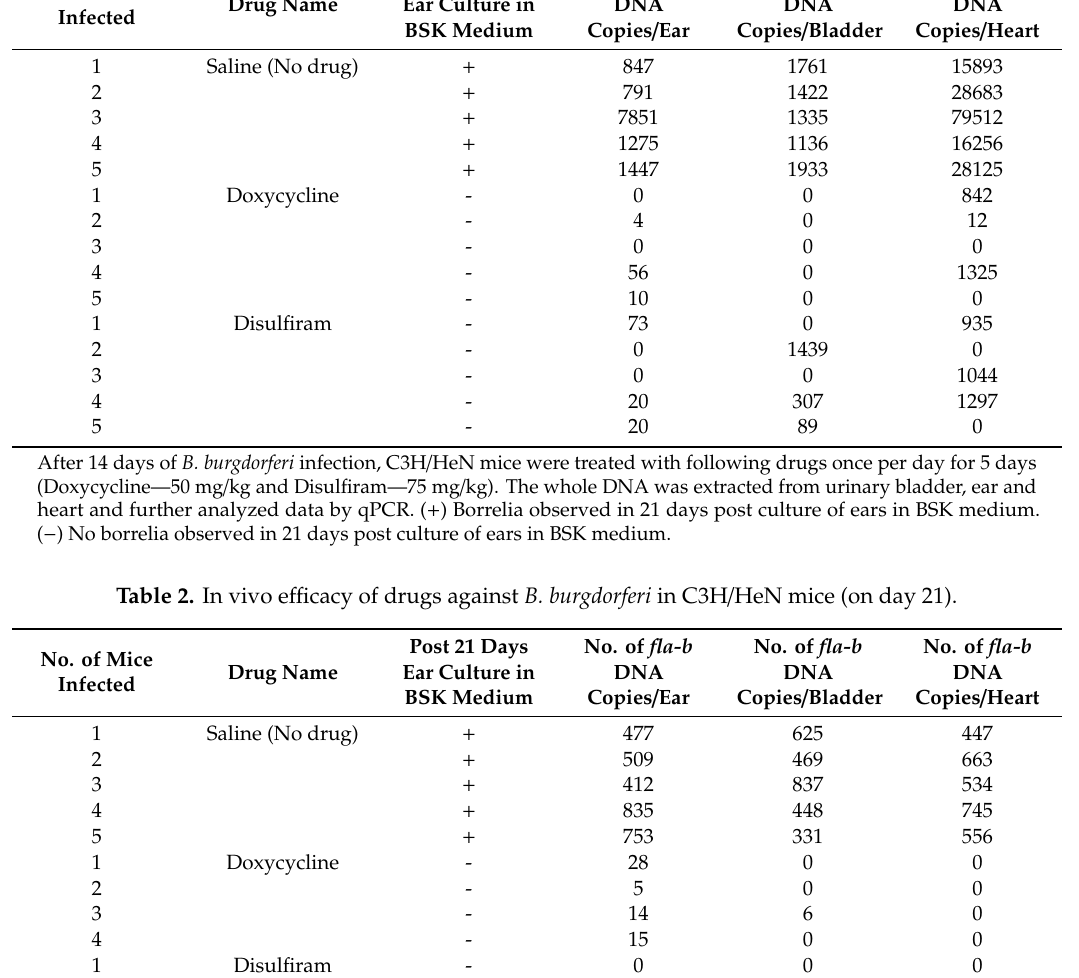
Table 1. In vivo e ffi cacy of drugs against B. burgdorferi in C3H / HeN mice (on day 14). No. of Mice